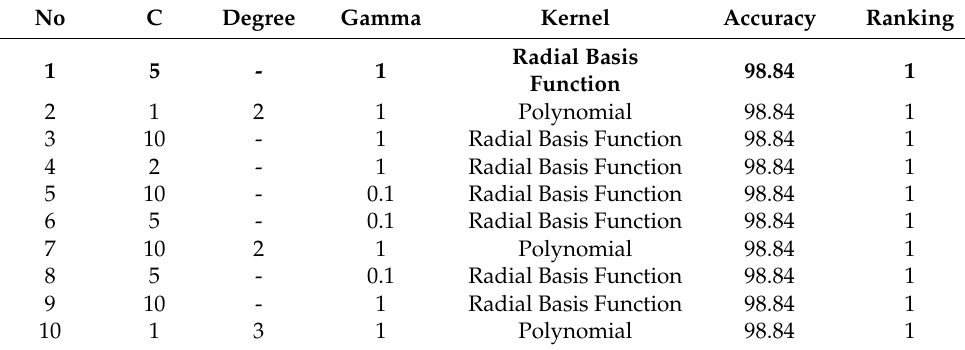
Table 8. Support Vector Machine algorithm hyperparameter optimization results.